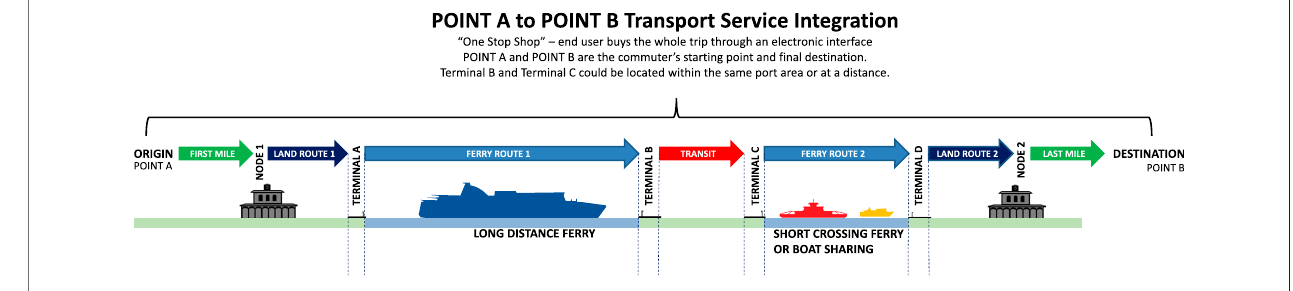
FIGURE 1 | A demonstrative example of a sea trip chain (A → B) and the contribution of Maritime MaaS. Source: Own Elaboration.